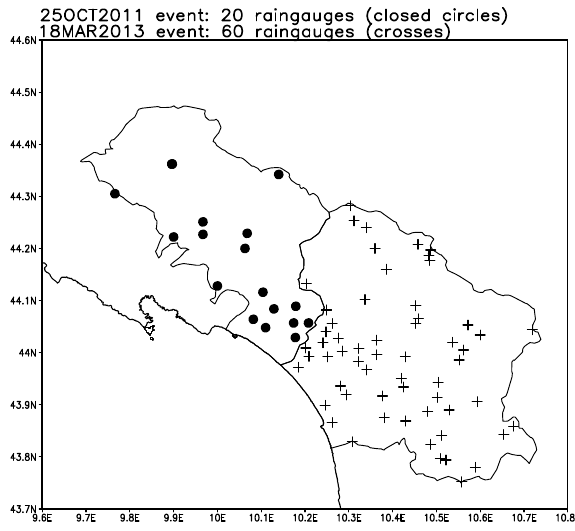
Figure 3. Locations of the rain-gauges for the two study cases: 25OCT2011 (closed circles) and 18MAR2013